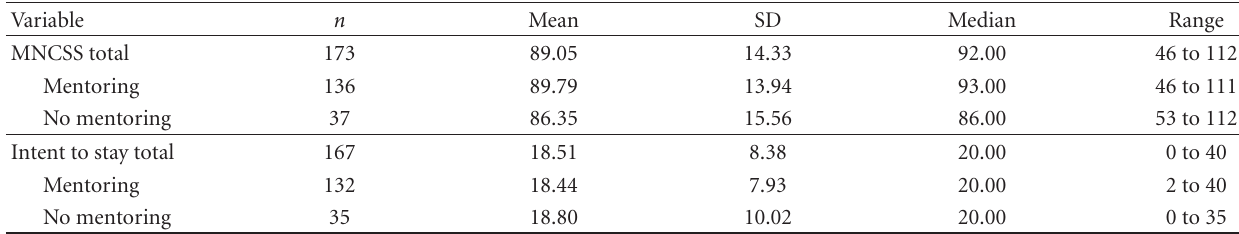
Table 3: Mean scores of career satisfaction and intent to stay in nursing.